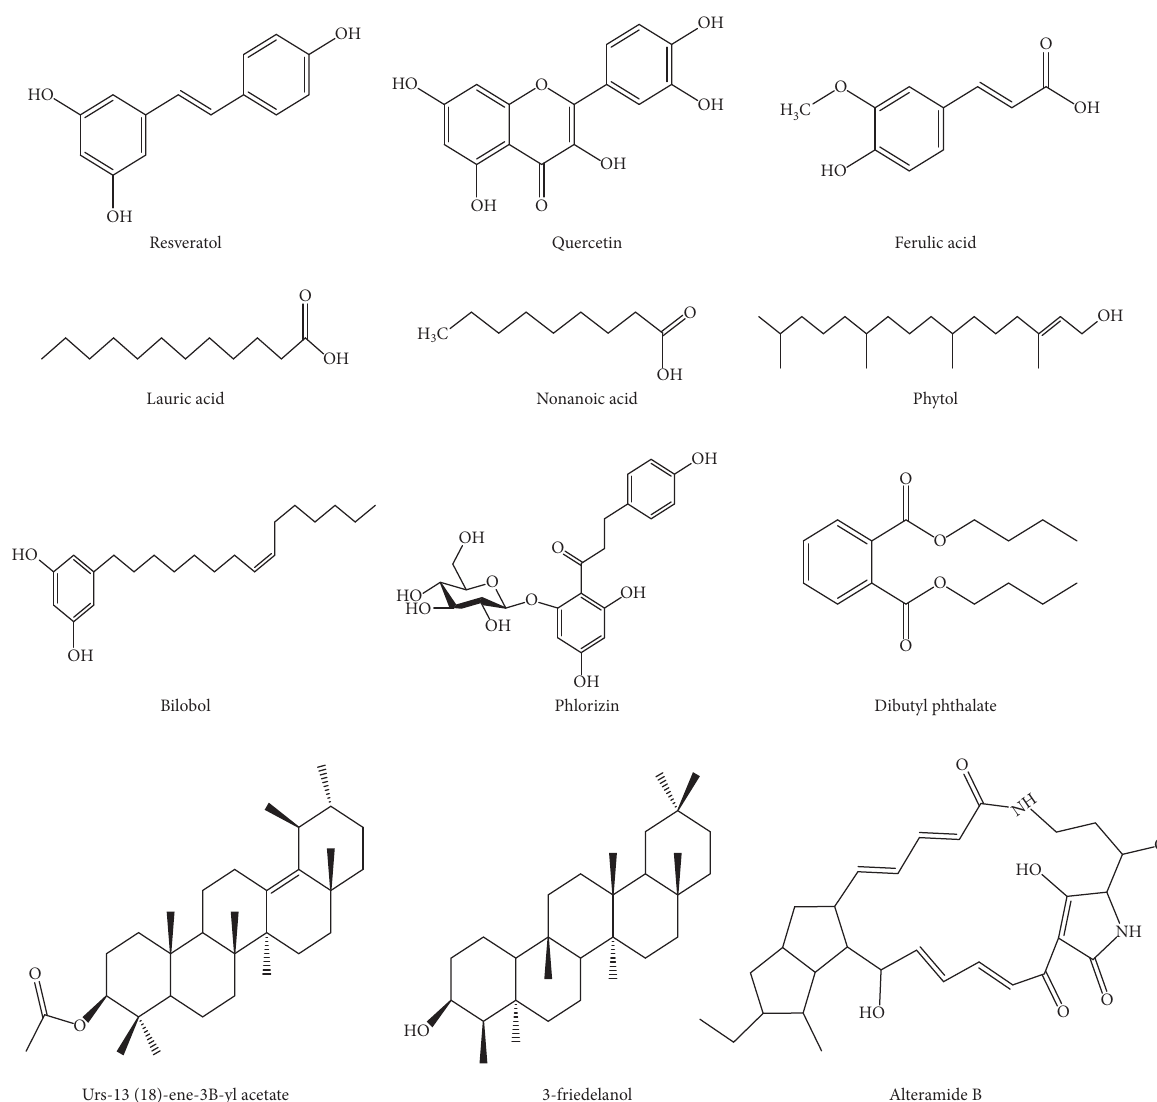
Figure 2: Relevant natural fungicidal